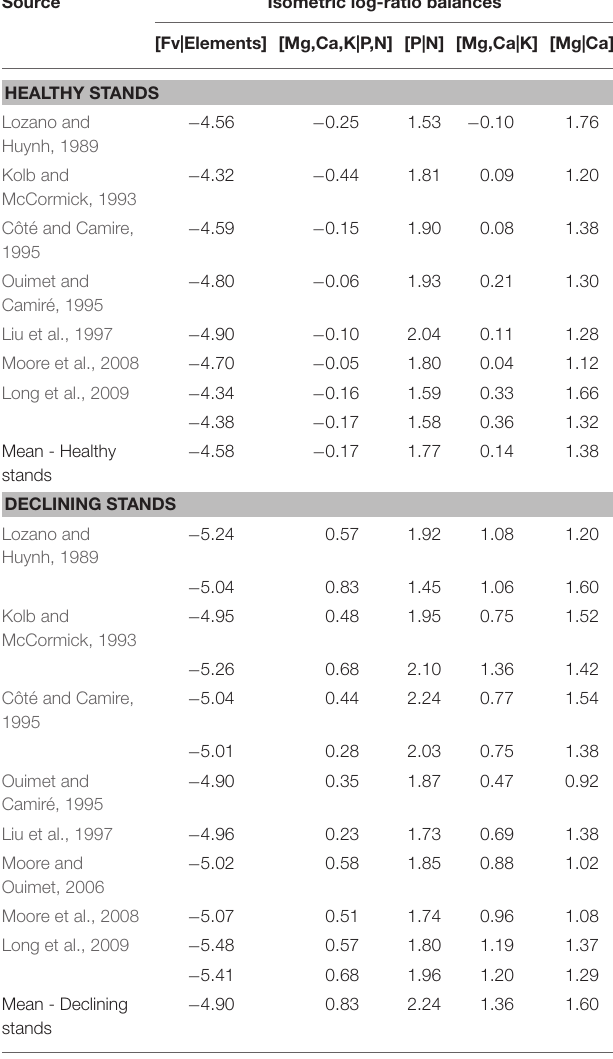
TABLE 4 | Linear model comparisons between foliar ilr balances (response variables) of sugar and red maple seedlings and forest floor pH. R ² adjusted R ² Var F -value P -value